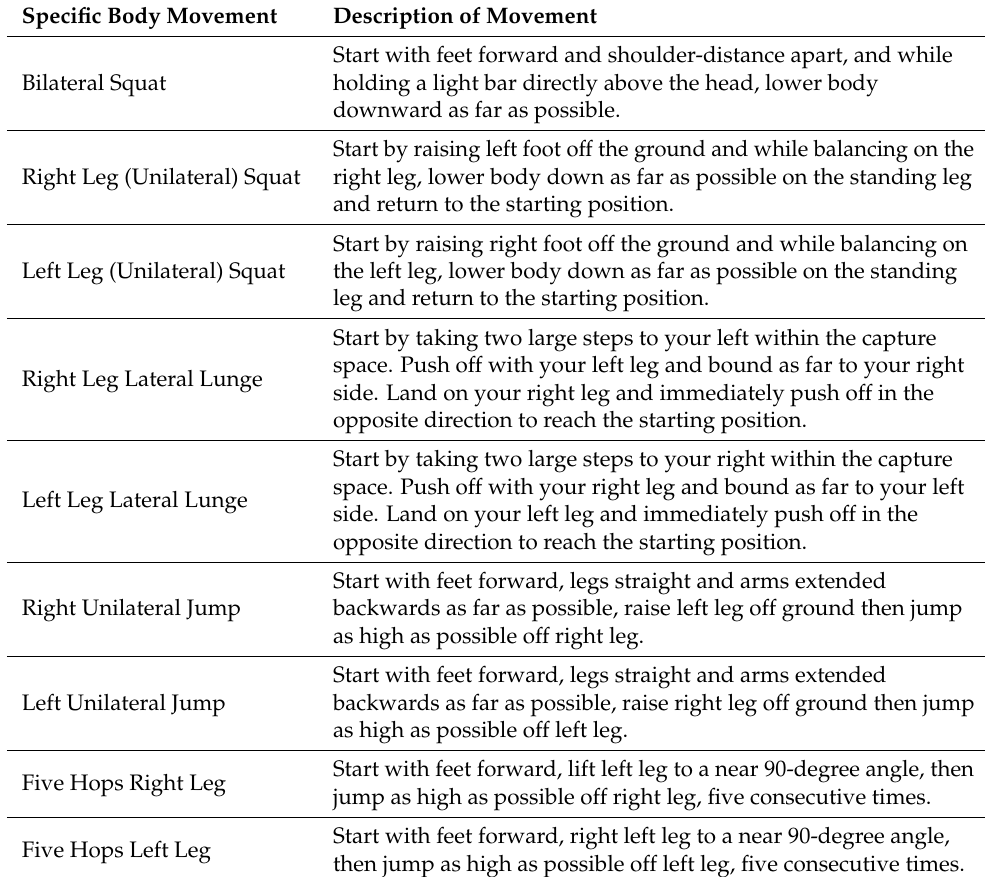
Table 1. List and description of body movements incorporated into screening